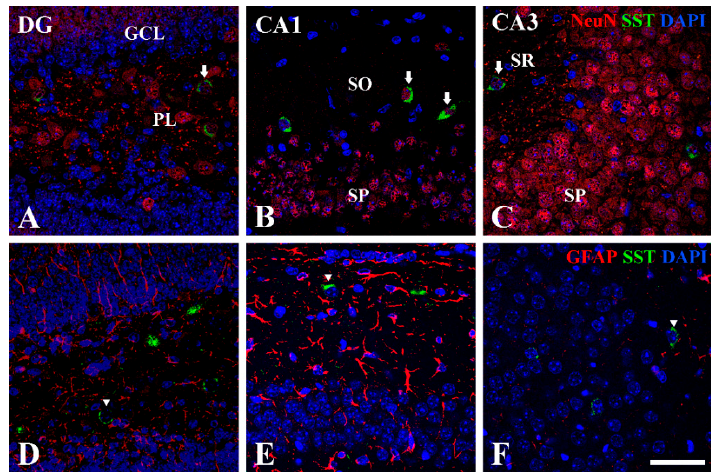
Figure 5. Double immunofluorescence staining for NeuN (red, ( A – C )) and GFAP (red, ( D – F )) with SST (green, ( A – F )) in the hippocampal dentate gyrus, CA1, and CA3 regions at P14. DAPI is expressed as blue in all images. SST immunoreactivity is co-localized only with NeuN-positive cells (arrows), not GFAP-positive cells in the PL, SO, and SR. GCL granule cell layer; PL polymorphic layer; SO stratum oriens; SP stratum pyramidale; SR stratum radiatum. Scale bar = 50 µm.